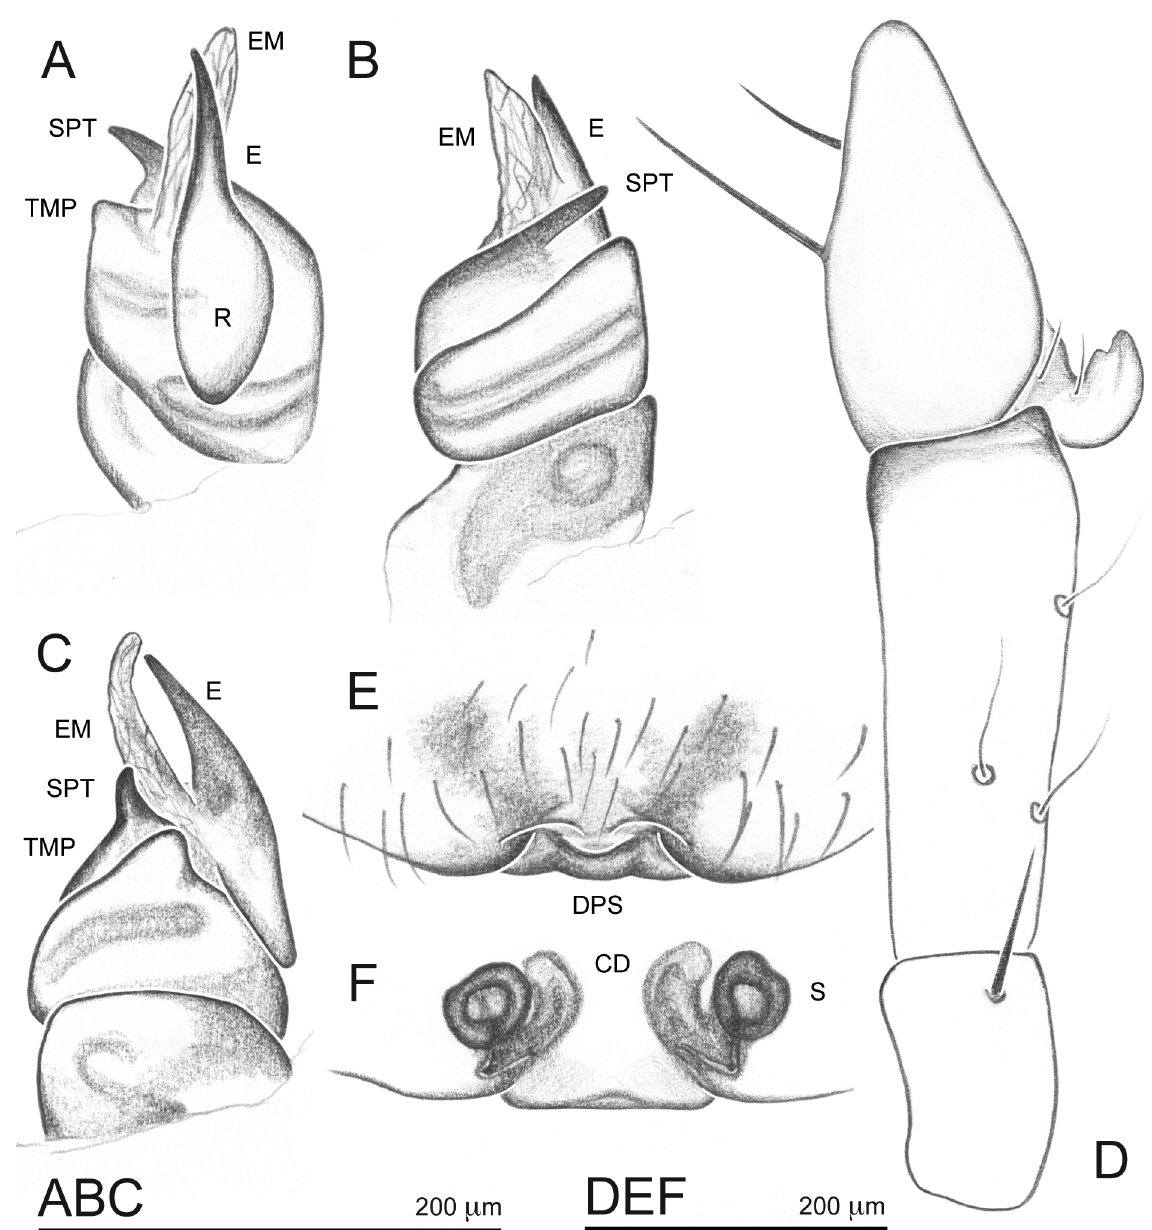
Fig. 8. Afroneta elgonensis Merrett, 2004. A–D . Allotype, ♂ (UPSZMC 67572). A . Bulbus, prolateral. B . Dorsal. C . Ventral. D . Palp, dorsal. E–F . ♀ (UPSZMC 67572). E . Epigyne, ventral. F . Vulva,